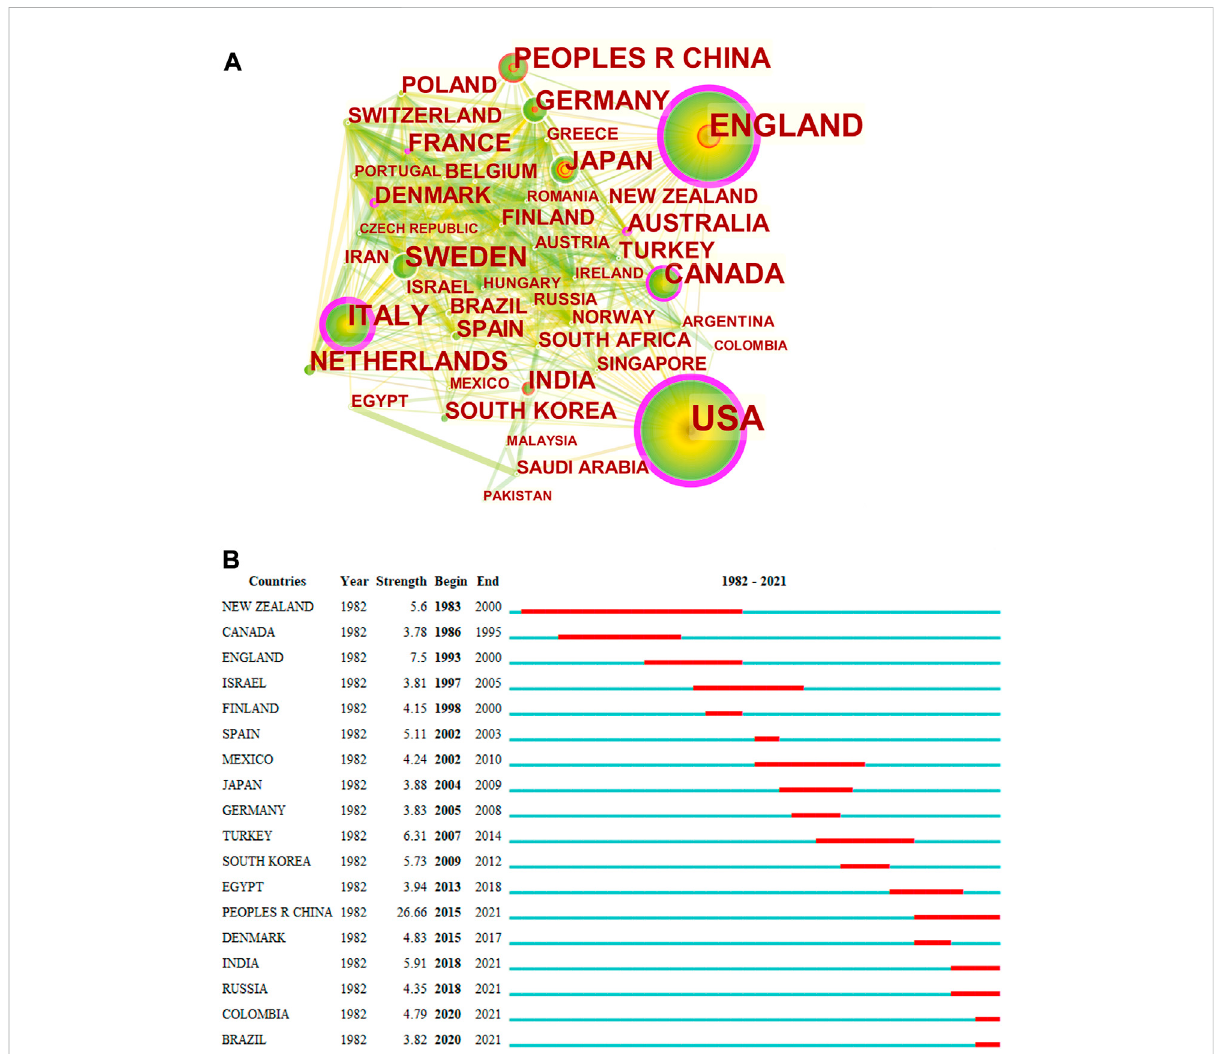
FIGURE 1 CiteSpace network map of countries/regions and top 18 countries with strongest citation bursts involved in asthma drug-related research. Notes: (A) CiteSpace network map of countries/regions involved in asthma drug-related research. The size of each node represents the number of publications of each country/region. The thickness of the links between nodes indicates the close degree of the cooperative relationship between countries/regions. (B) Top 18 countries with strongest citation bursts in asthma drug-related studies. The strongest citation burst means that a variable changes greatly in a short period. The blue line represents the base timeline, and the red part indicates the burst duration of each